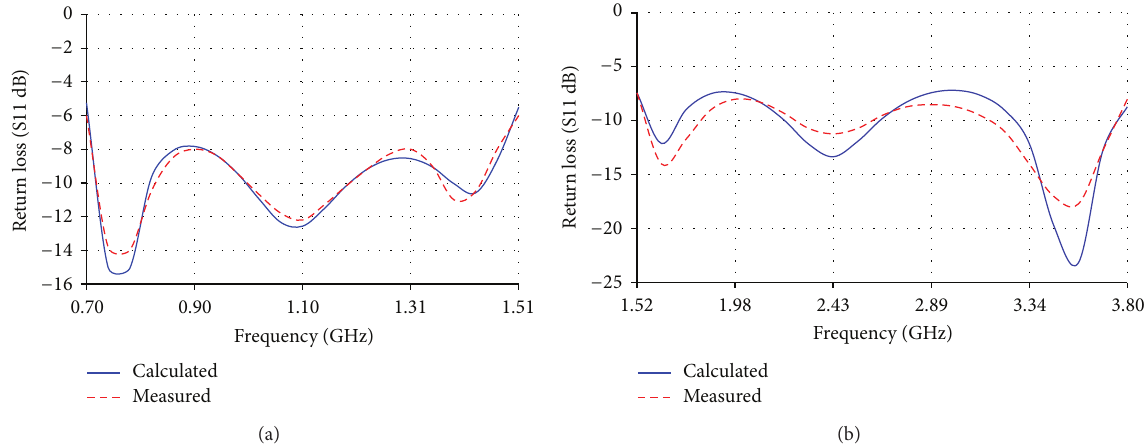
Figure 2: Return loss (S11) of (a) the low band antenna and (b) the high band antenna.